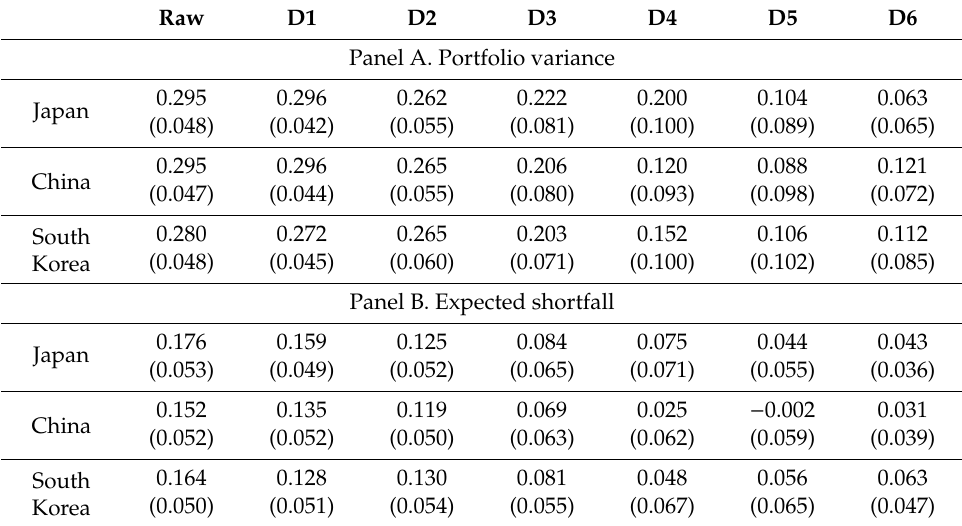
Table 5. Portfolio variance and expected shortfall reduction e ff ectiveness of oil-stock portfolios at multiple time scales. Raw